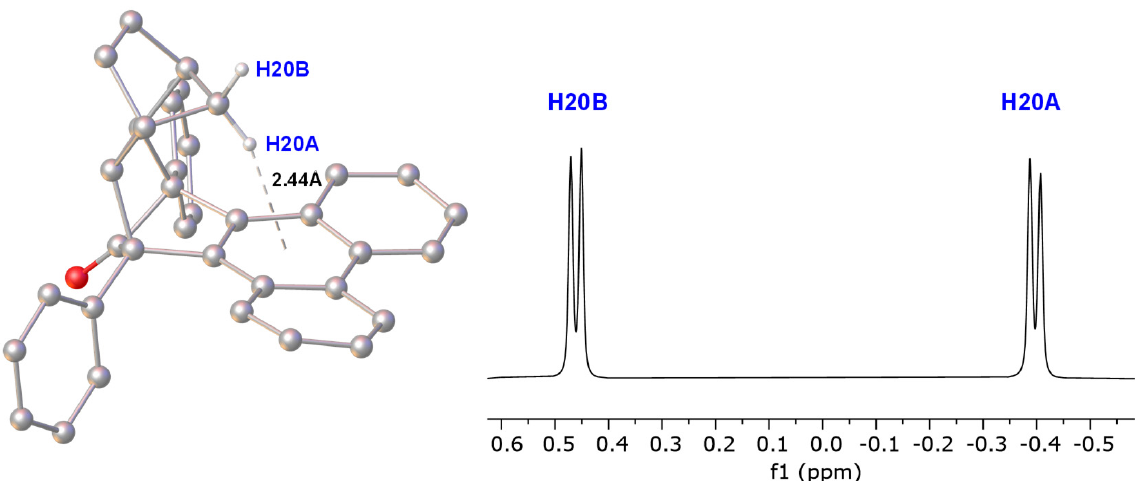
Figure 1. 1 H NMR spectrum expansion showing the norbornyl bridgehead CH 2 signals of bicy- clo[2.2.1]heptene 3 . The X-ray crystal structure has been superimposed and the distance between H20A and the phenanthrene ring system (2.44 Å) is highlighted.